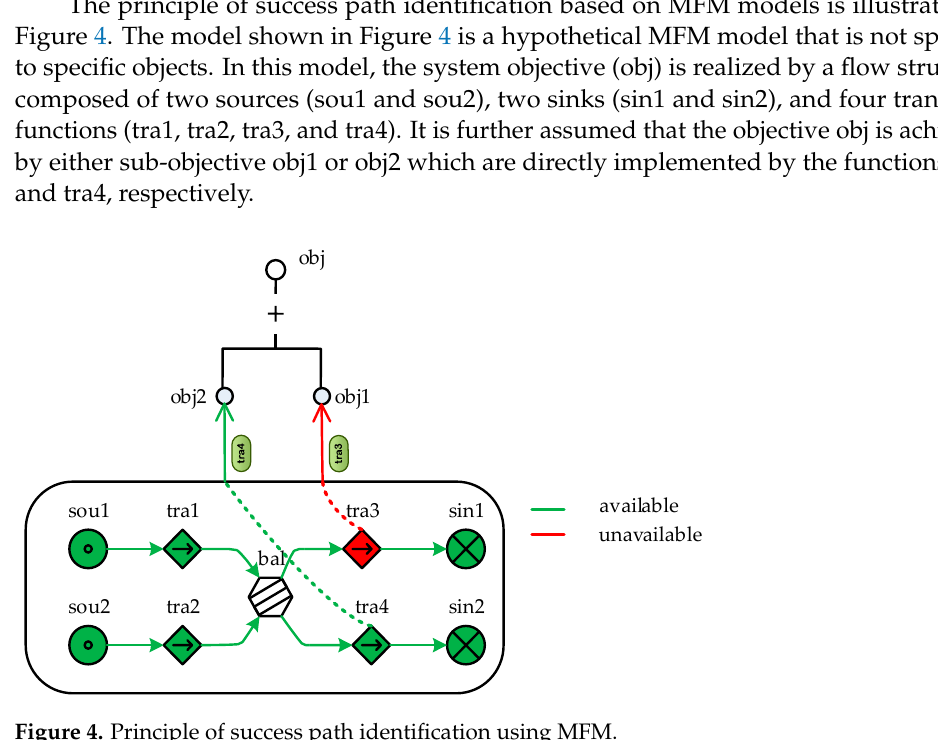
Figure 4. Principle of success path identi fi cation using MFM.